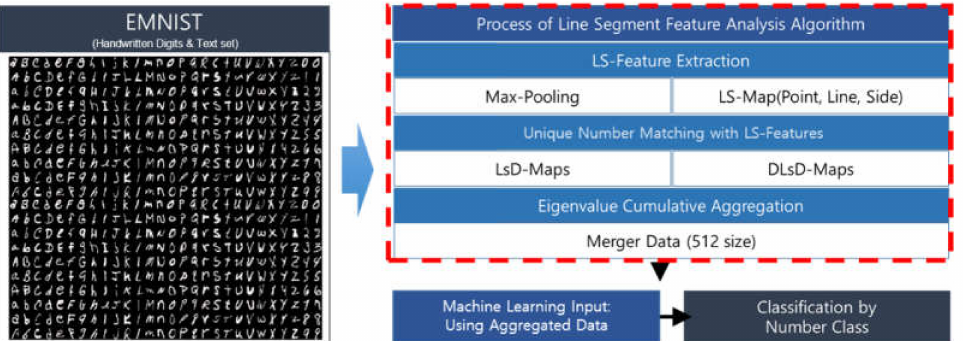
Figure 3. Flow of the line-segment feature analysis algorithm for input dimensionality reduction.